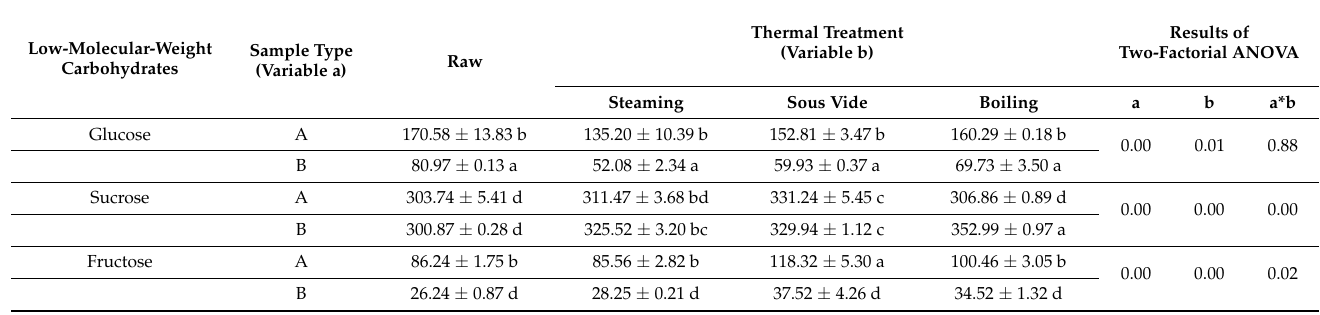
Table 6. Content of low molecular weight carbohydrates in Brussels sprouts that were raw and those subjected to hydrothermal treatments before and after in vitro digestion (mg/g